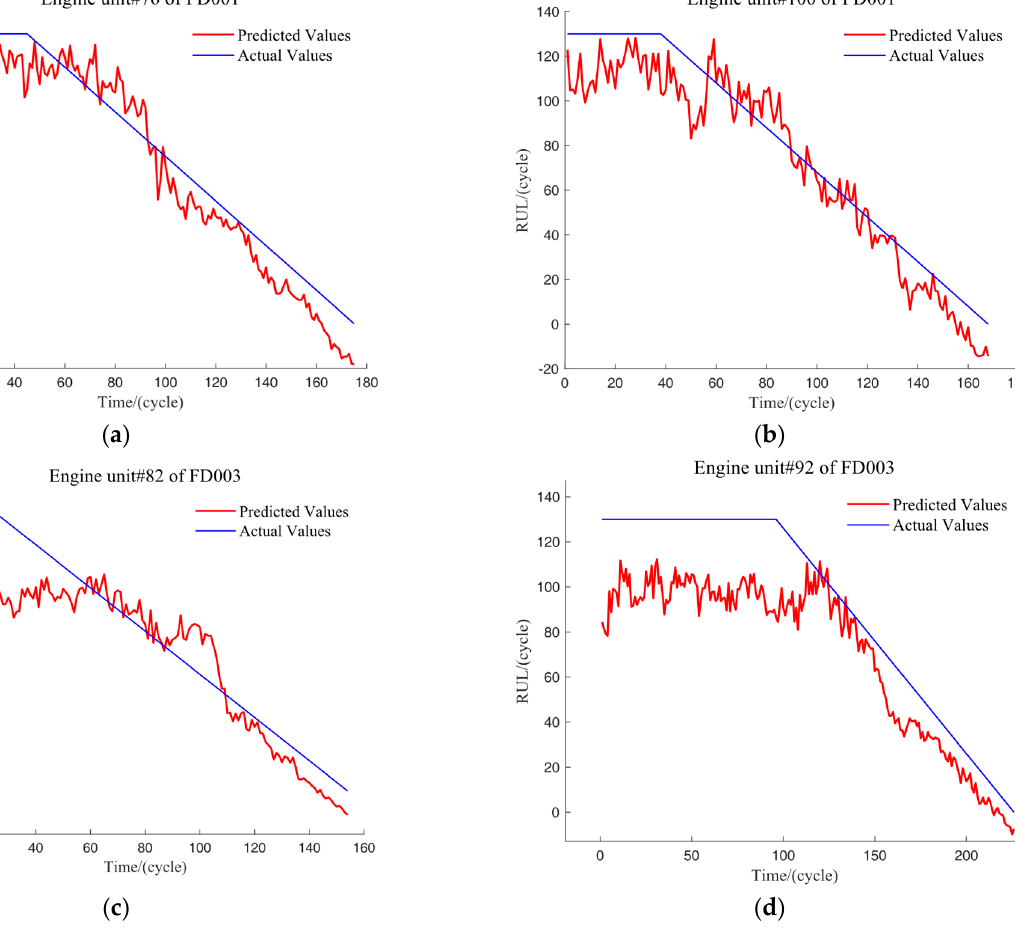
Figure 7. ( a , b ) RUL prediction results for engine units #76 and #100 of FD001; ( c , d ) RUL prediction results for engine units #82 and #92 of FD003.